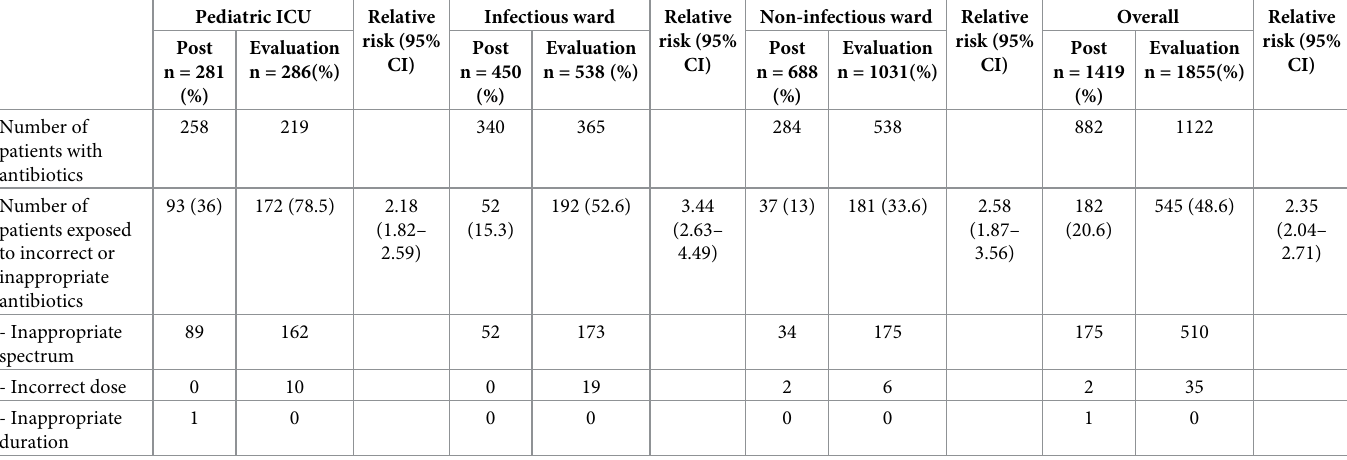
Table 4. The incidence of antibiotic use and irrational use of antibiotics over the study